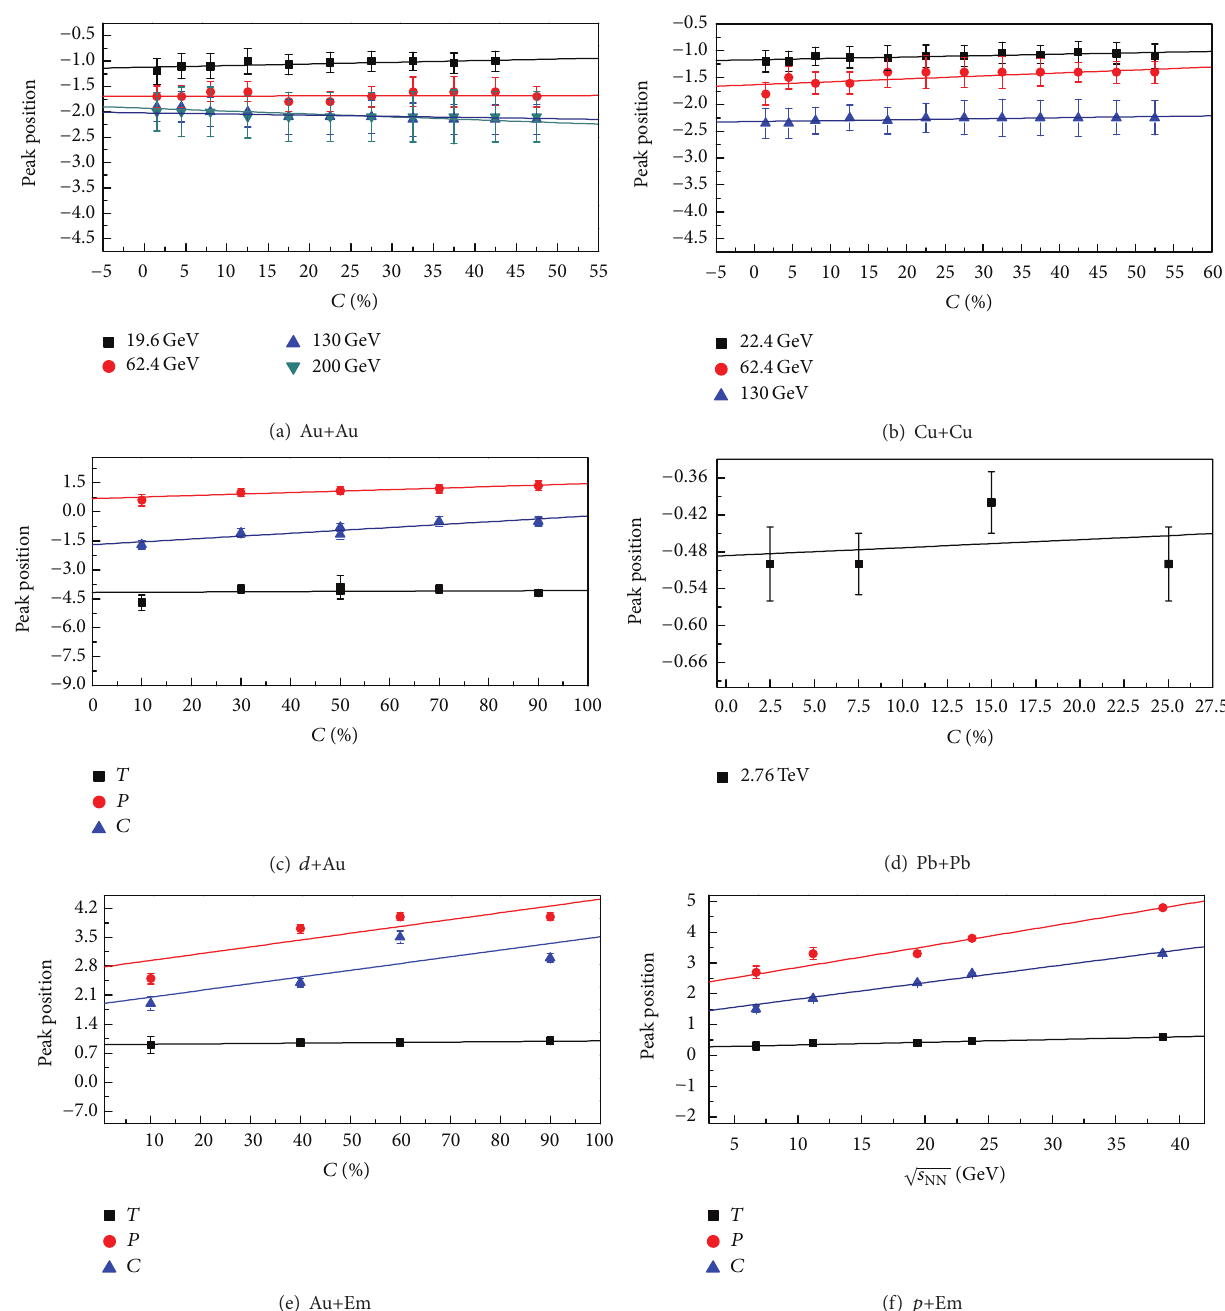
Figure 12: Dependencies of peak positions ( 𝑦 𝑇 , 𝑦 𝐶 , and 𝑦 𝑃 ) of rapidity distributions in Au-Au, Cu-Cu, 𝑑 -Au, Pb-Pb, Au-Em, and p -Em collisions on 𝐶 or √𝑠 NN , where for symmetric collisions 𝑦 𝐶 and 𝑦 𝑃 are not presented due to the fact that 𝑦 𝐶 = 0 and 𝑦 𝑃 = −𝑦 𝑇 . The symbols are quoted in Tables 1–6, and the lines are our fitted results. Table 6: This table is the same as Table 4 but shows the results for the curves in Figure 11 which shows 𝑝 -Em collisions at different √𝑠 Figure Figure 11(a) 6.7 GeV 0.30 ± 0.15 1.50 ± 0.10 2.70 ± 0.20 0.03 ± 0.01 0.10 ± 0.02 1.00 ± 0.04 0.368 0.231 ± 0.046 0.273 ± 0.019 Figure 11(b) 11.2 GeV 0.40 ± 0.10 1.85 ± 0.07 3.30 ± 0.20 0.10 ± 0.02 0.08 ± 0.01 1.20 ± 0.02 0.594 0.169 ± 0.035 0.279 ± 0.008 Figure 11(c) 19.4GeV 0.40 ± 0.05 2.35 ± 0.05 3.30 ± 0.10 0.13 ± 0.02 0.10 ± 0.02 1.30 ± 0.04 0.422 0.131 ± 0.028 0.254 ± 0.014 Figure 11(d) 23.7 GeV 0.46 ± 0.03 2.65 ± 0.05 3.80 ± 0.07 0.15 ± 0.02 0.10 ± 0.02 1.35 ± 0.04 0.749 0.121 ± 0.026 0.252 ± 0.013 Figure 11(e) 38.7 GeV 0.60 ± 0.08 3.30 ± 0.05 4.80 ± 0.05 0.15 ± 0.02 0.04 ± 0.02 1.70 ± 0.04 0.296 0.102 ± 0.022 0.321 ±